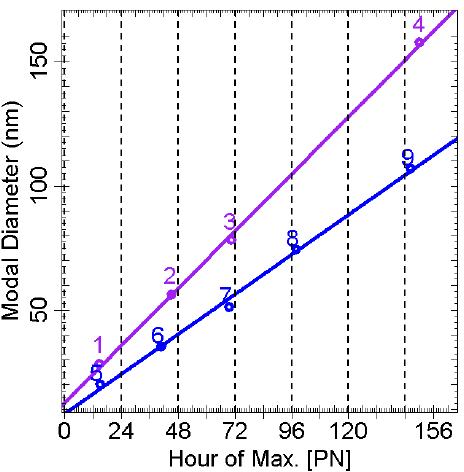
Figure 1. Location of the 24 EUSAAR and GUAN stations in Table 1